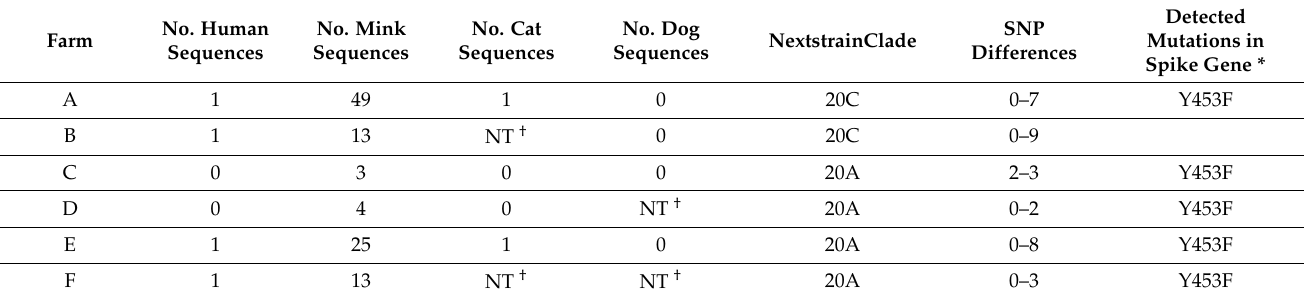
Table 4. Phylogenetic analysis of sequences derived from human and animal specimens from six mink farms in